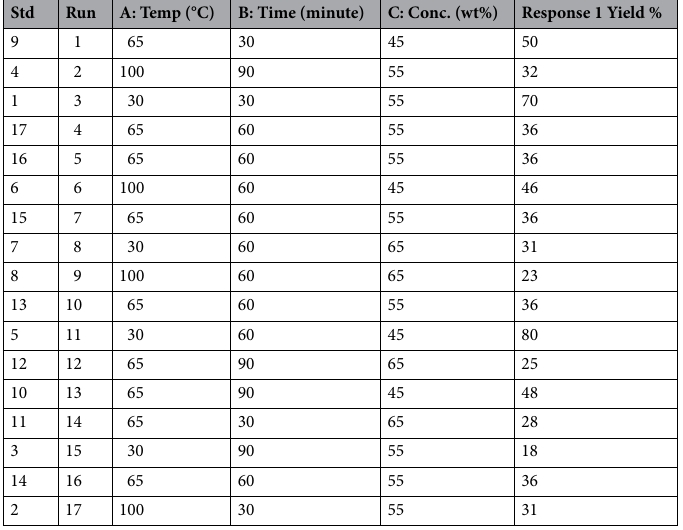
Table 2. Experimental design based on BBD with the response (Yield